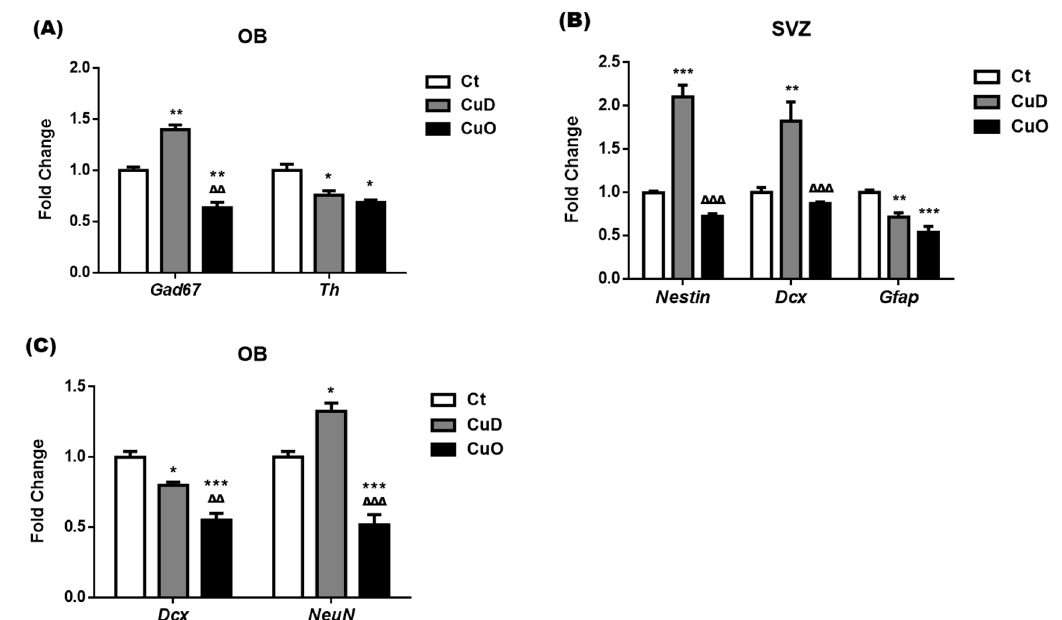
Figure 4. mRNA expression of neuronal markers following CuD or CuO treatment. The expression of neural markers was quantified by qPCR. ( A ). mRNA expression of Gad67 and Th in the OB. ( B ). mRNA expression of Nestin, Dcx, and Gfap in the SVZ. ( C ) mRNA expression of Dcx and NeuN in the OB. Data represents mean ± SEM, n = 6–7/group. *: p < 0.05, **: p < 0.01, ***: p < 0.001, as compared to the correspondent Ct group; ∆∆ : p < 0.01, ∆∆∆ : p < 0.001, as compared to the correspondent CuD group; using one-way ANOVA analysis. Ct: control; CuD: Cu deficiency; CuO: Cu overload; SVZ: subventricular zone; OB: olfactory bulb.